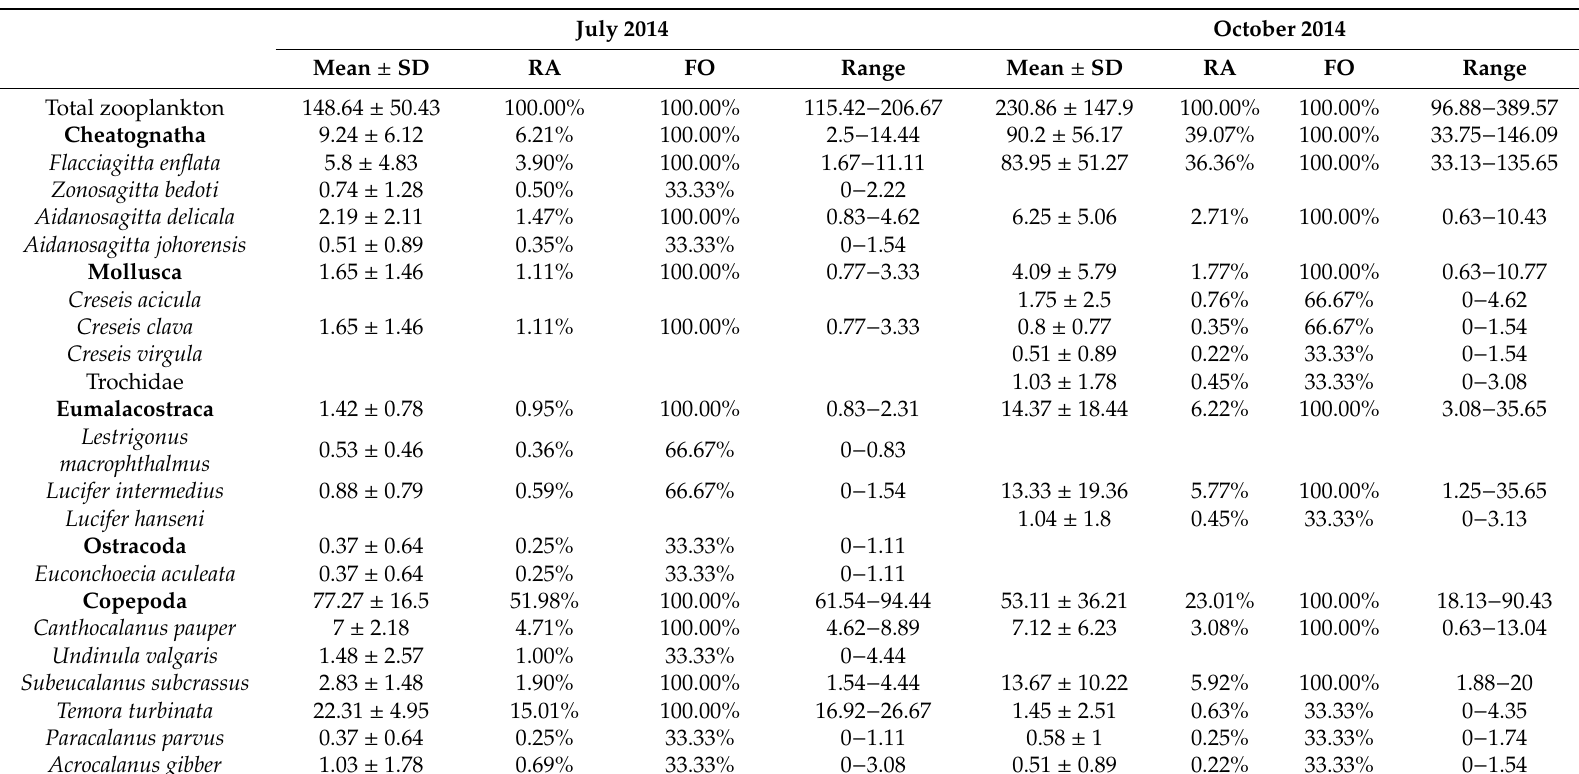
Table A1. Mean ( ± SD) abundance (ind m − 3 ), relative abundance (RA), frequency of occurrence (FO) and abundance range of all zooplankton species found in Sanya